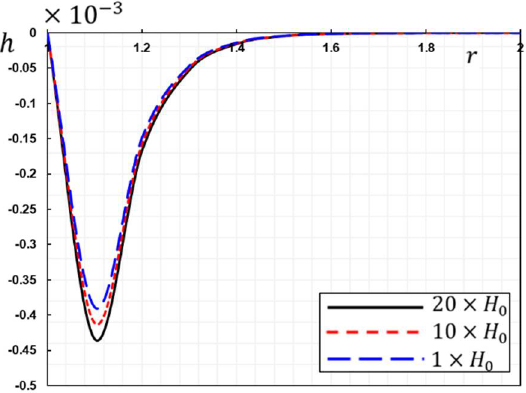
Figure 5. The hoop thermal stress, σ ξξ , versus the axial magnetic field, H 0 .